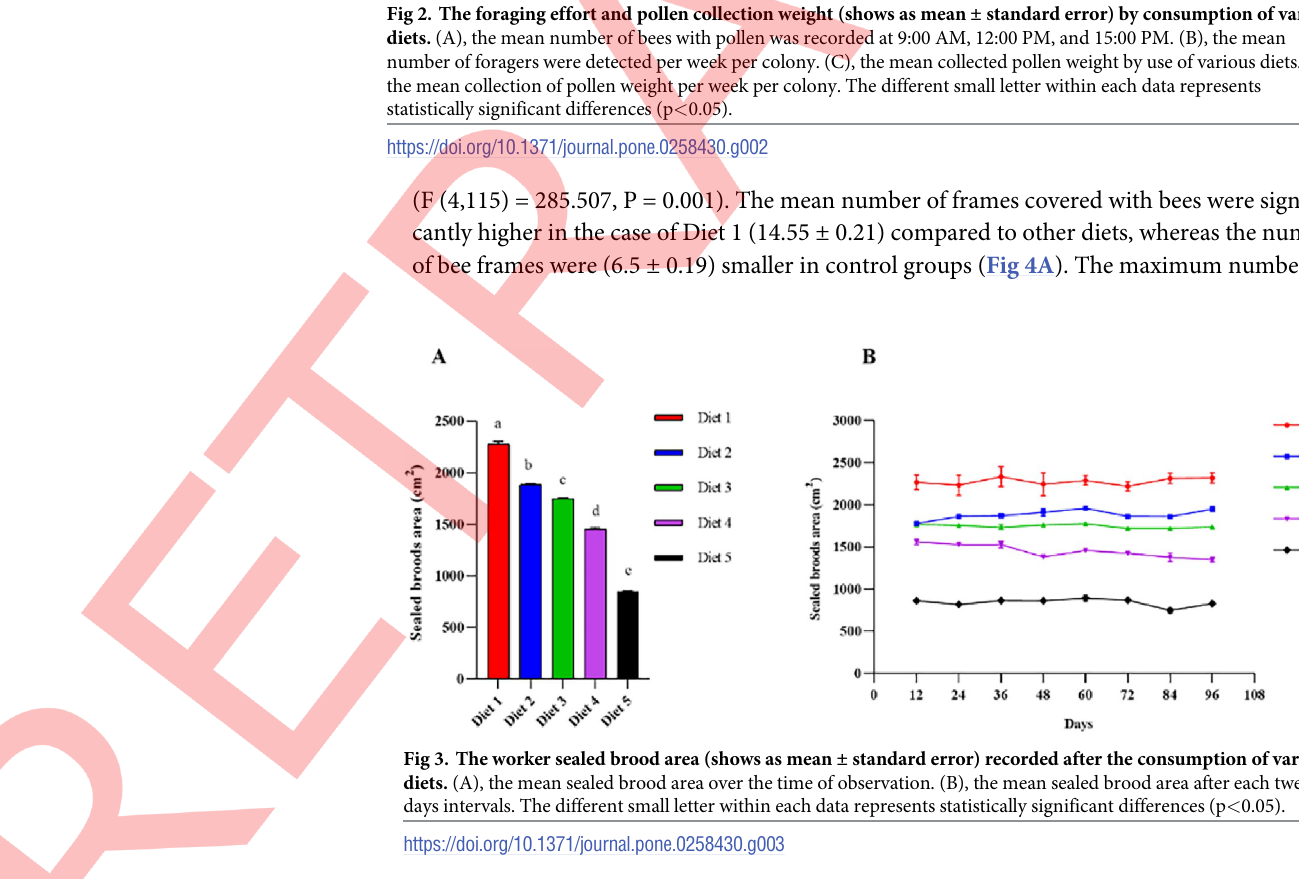
(F (4,115) = 285.507, P = 0.001). The mean number of frames covered with bees were signifi- cantly higher in the case of Diet 1 (14.55 ± 0.21) compared to other diets, whereas the number of bee frames were (6.5 ± 0.19) smaller in control groups ( Fig 4A ). The maximum number of